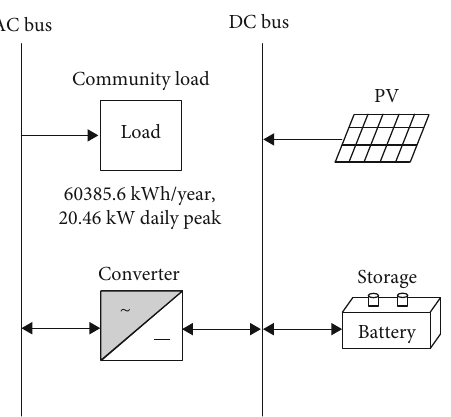
Figure 13: Sketch of the nonnetworked PV minigrid with